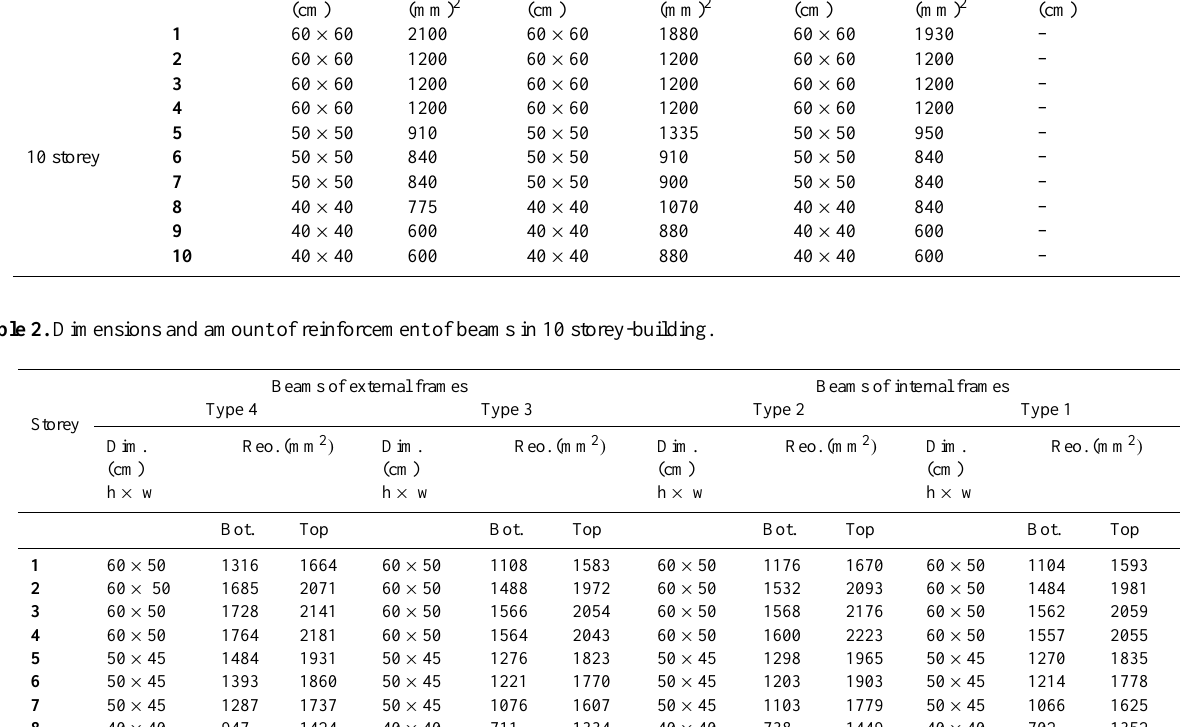
Table 1. Dimensions and amount of reinforcement of columns and shear walls in the 10-storey building. Building